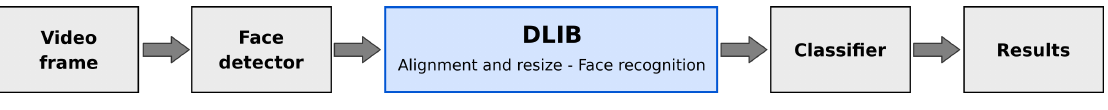
Figure 1. View of the former Dlib face recognition framework signal